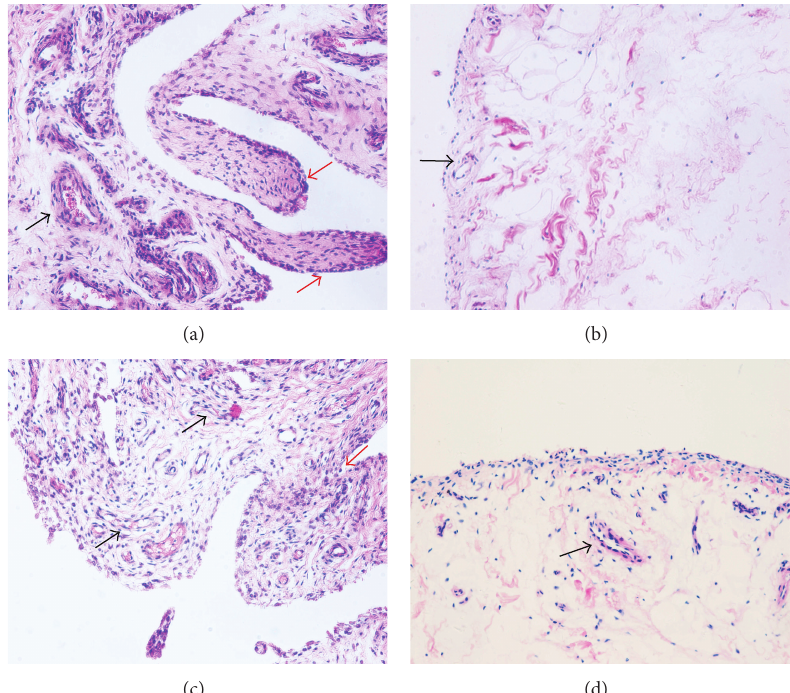
Figure 1: Hematoxylin eosin staining for synovial tissue (original magnification × 200). Hematoxylin eosin staining distinguished synovium of RA patients from synovium of controls. Inflammatory cell infiltration, synovial cell proliferation, and pannus formation are visible in synovium of RA patients ((a), (c)). Fewer inflammatory changes are detectable in synovium from knee trauma patients ((b), (d)). Red arrow: synovial cell proliferation. Black arrow: pannus